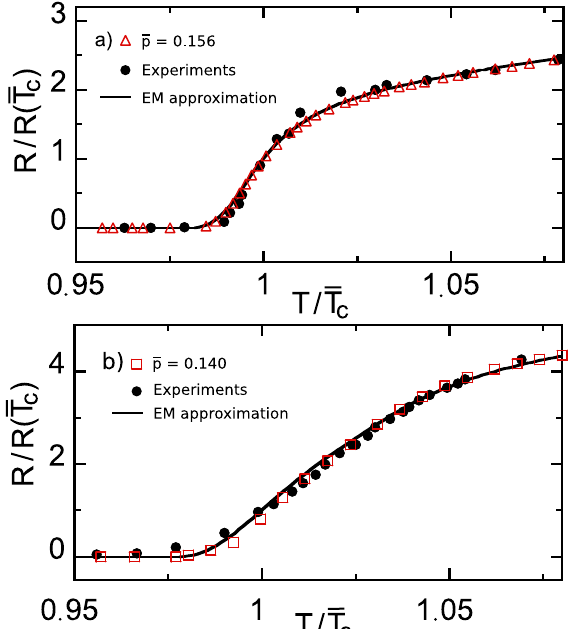
Figure 2. Comparison between The electrical resistance vs. temperature curves resulting from our methodology (open symbols for the finite-element computations and solid line for the EM analytical approximation) and the measurements of reference [48] (solid symbols), for YBCO films with uniform nominal oxygen stoichiometry corresponding to: in panel a) to p = 0.156, i.e., very near the maximum- T c doping level; in panel b) to p = 0.140, i.e., a T c -nanostructured nonpatterned HTS. Note that the normalization of the axes significantly zooms the transition region with respect to Figure